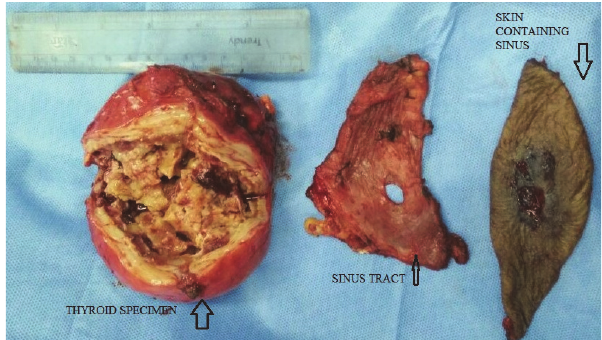
Figure 3: Cut section of thyroid showing greyish white color with extensive areas of autolysis and a cavityidentified in the centerof the